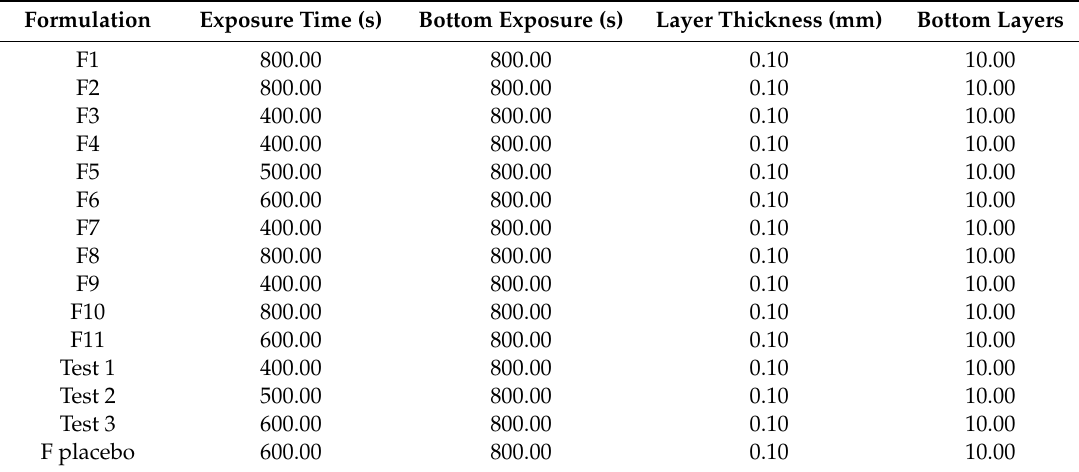
Table 2. Printing process parameters.